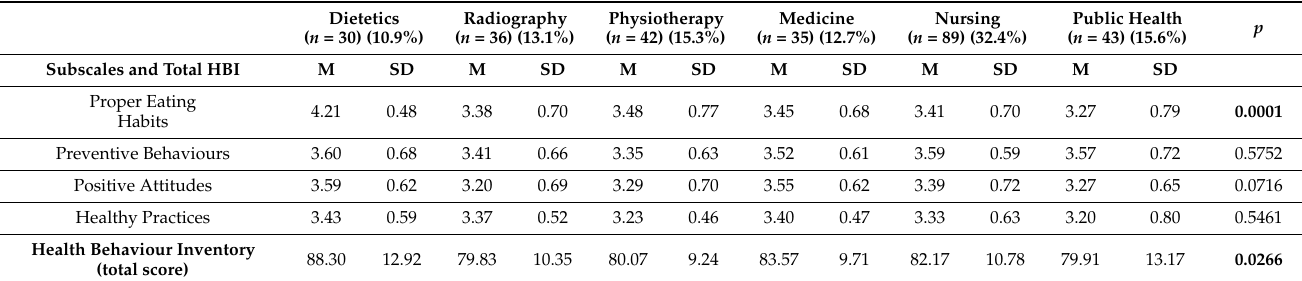
Table 5. Major of study vs. health behaviours.